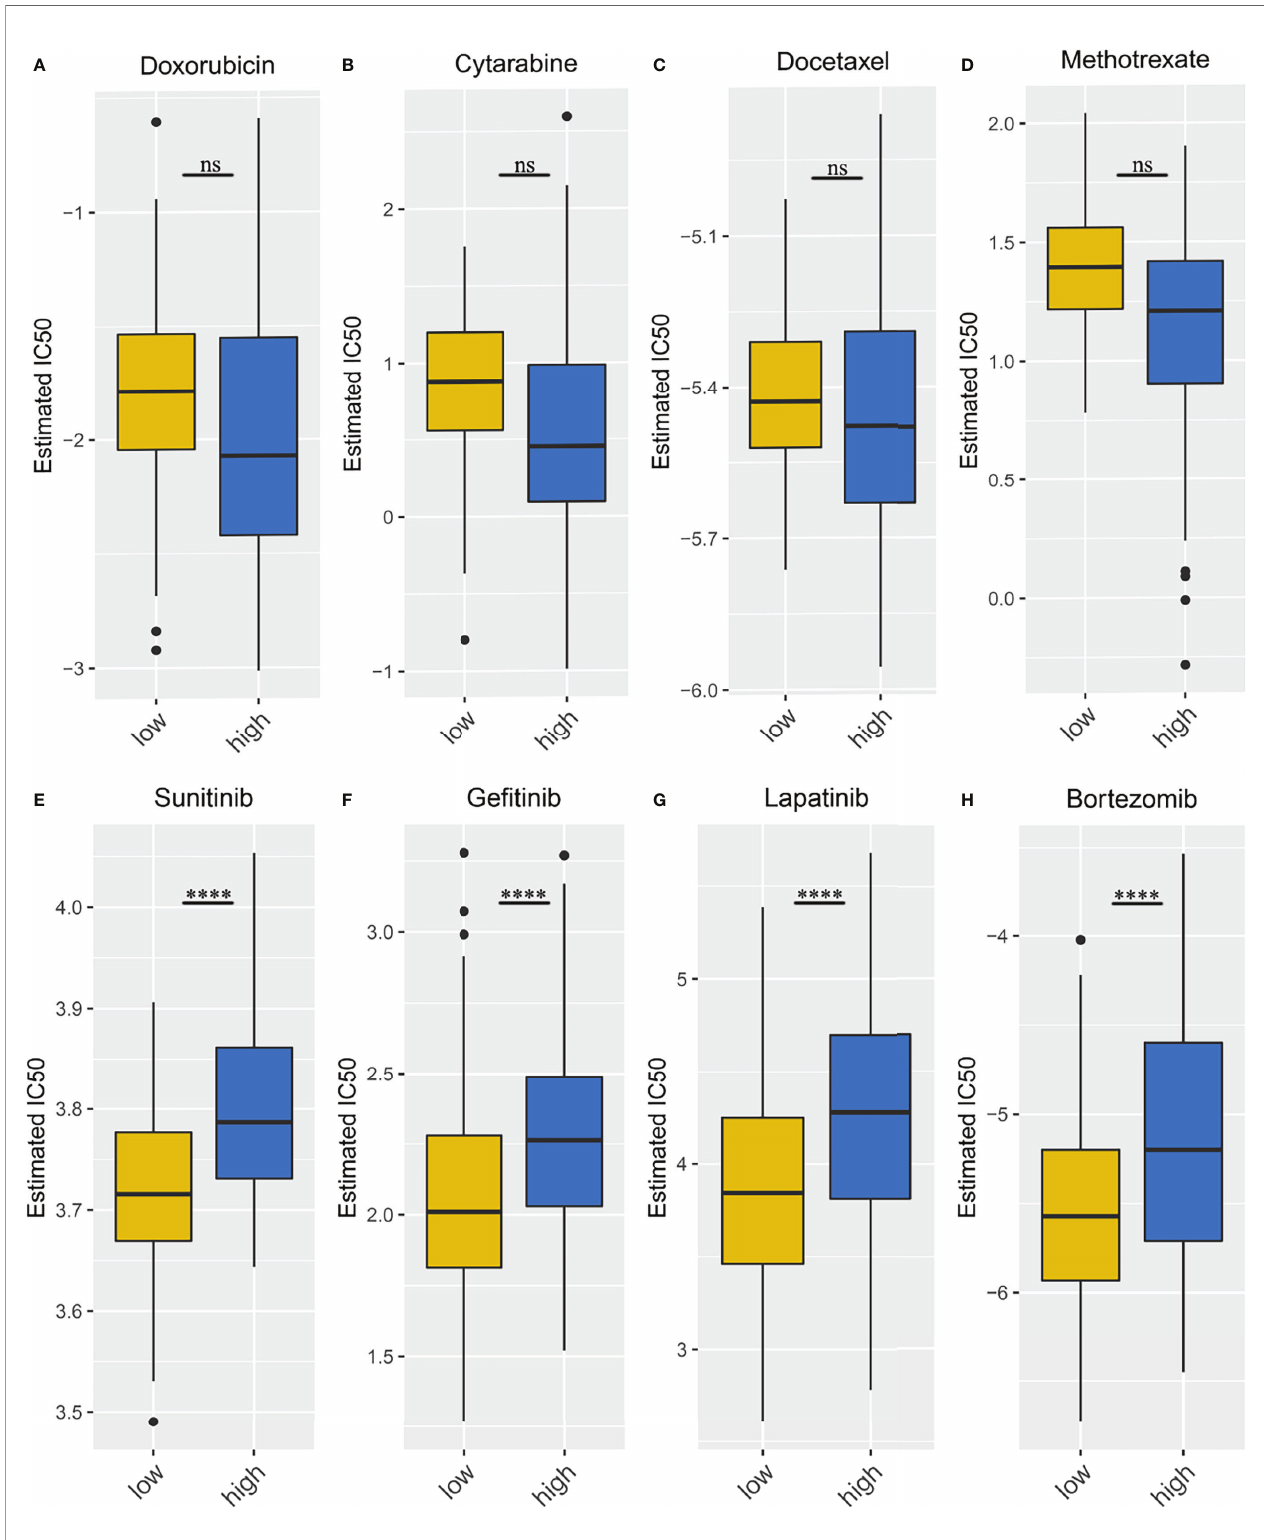
FIGURE 10 | Different immune/chemotherapy sensitivity analysis. (A – D) the box plots of the estimated IC50 for Doxorubicin, Cytarabine, Docetaxel, Methotrexate; (E – H) the box plots of the estimated IC50 for Sunitinib, Ge fi tinib, Lapatinib, and Bortezomib. ****p < 0.0001; ns, p ≥